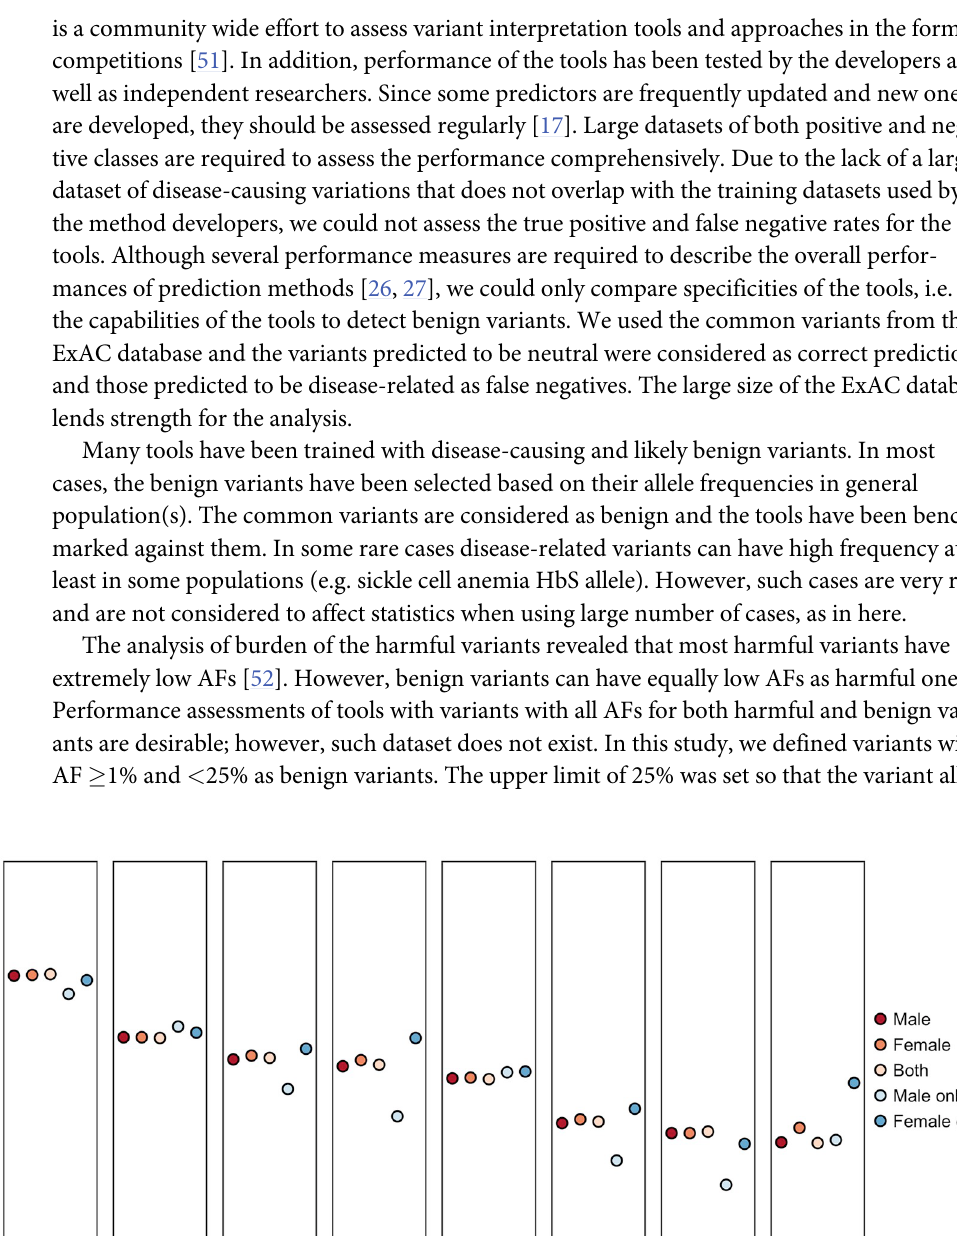
PLOS Computational Biology | https://doi.org/10.1371/journal.pcbi.1006481 February11,